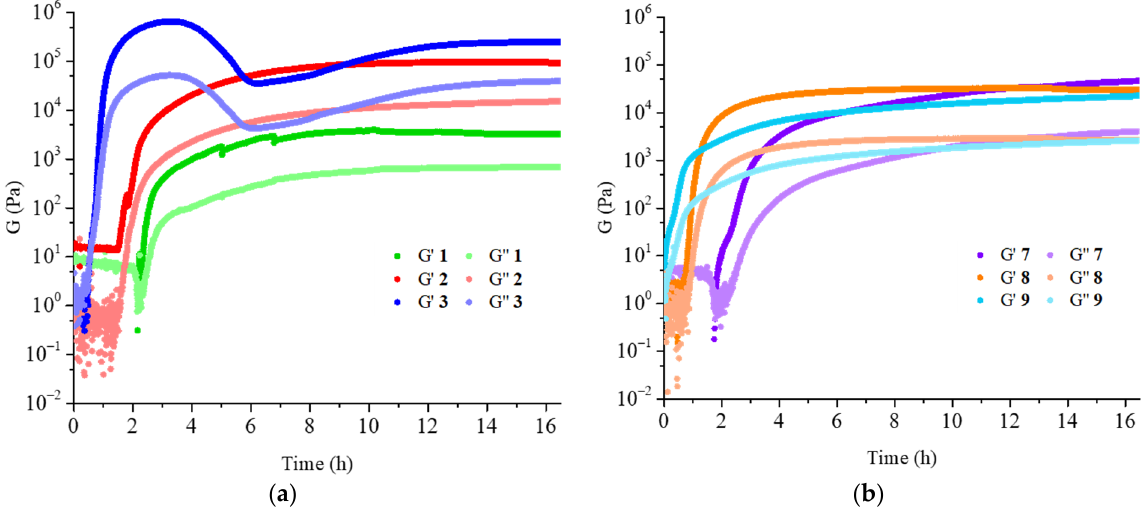
Figure 6. Time sweep of hydrogels ( a ) 1 – 3 and ( b ) 7 – 9 .